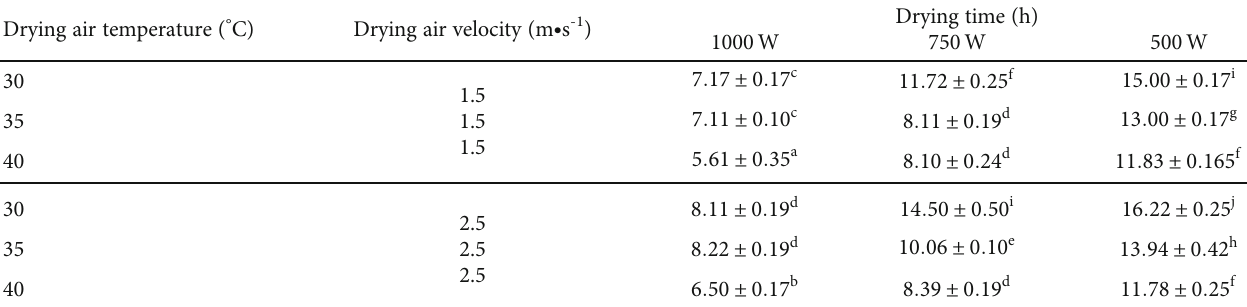
Table 4: Summary of the drying time for marinated beef at the selected drying